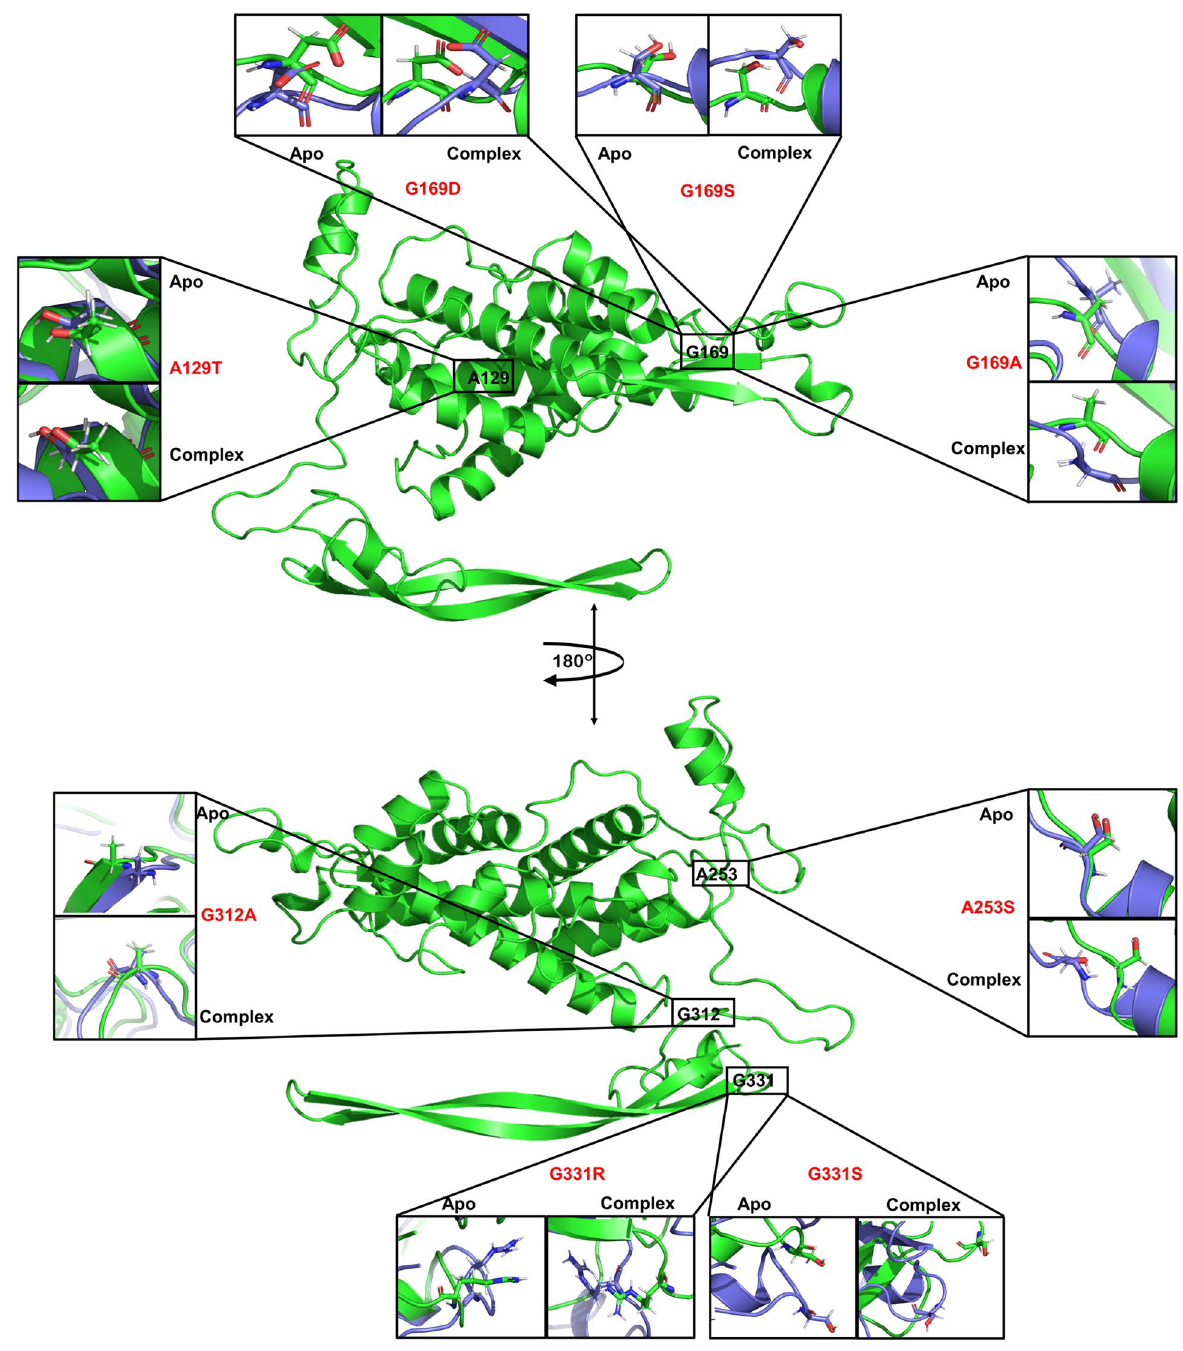
Figure 3. Positions of some selected residues on Wnt1 (full structures, shown in green) have been shown; two orientations have been created with a 180º rotation around an axis that was chosen for the convenience of presentation. The positions of the selected residues have been zoomed in and then the orientations of their side chains of the corresponding mutants in apo and complexes have been shown. The structures before (green) and after (violet) the MD simulation have been shown. Each mutant refers to two zoomed in boxes, i.e. for apo and complex, which have been indicated for each FZD-5, FZD-7, FZD-8 and FZD-10 through HDOCK, HADDOCK and ClusPro server 52 . The N-terminal 27 amino acid long signal sequence of Wnt1 was cleaved off before docking 70 . The interaction interfaces between wild type Wnt1 and FZD-CRDs were then evaluated on the basis of docking score (DS) from HDOCK, Z-score from HADDOCK and balanced weighted score from ClusPro (Table 4). Different types of binding interaction pattern of each docked wild type Wnt1 against seven different frizzled receptors are obtained from PDBsum and the details are given in Supplementary Table S7 and Supplementary Fig. S9. It was observed that Wnt1 had